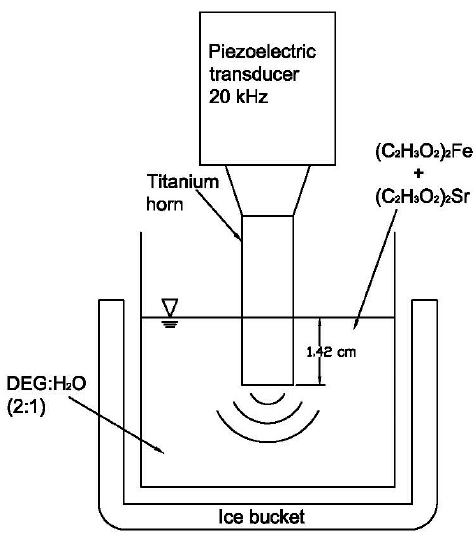
Figure 1. Schematic diagram of experimental sonochemical set up.